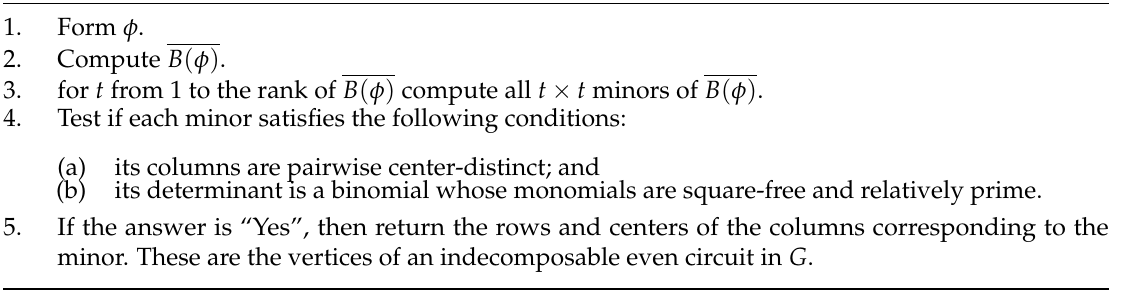
Algorithm 1 To enumerate all indecomposable even circuits in a given graph